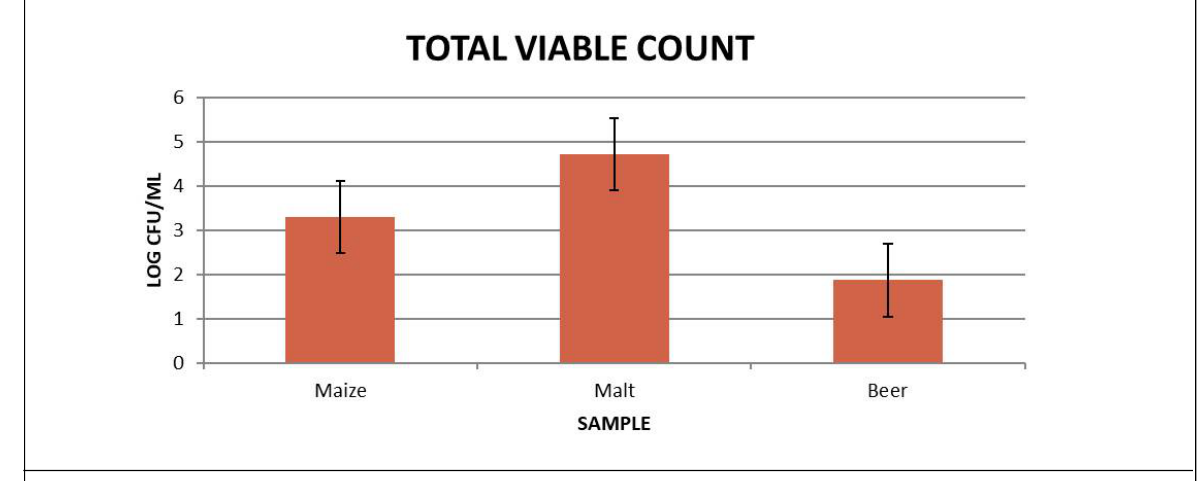
Figure 3: Total bacterial count in maize, malt and beer